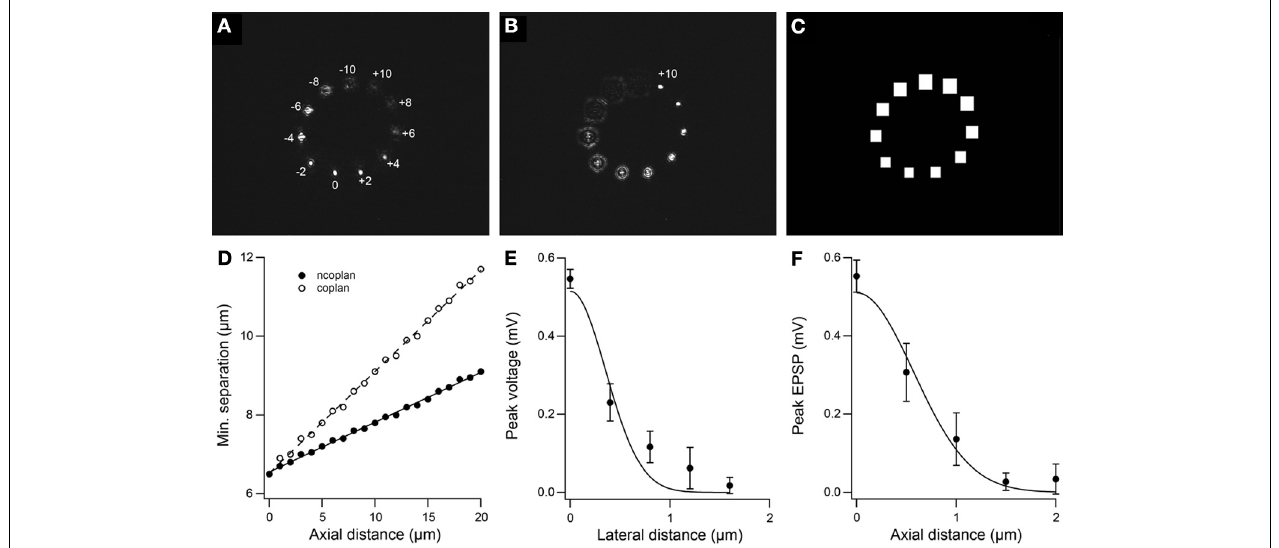
FIGURE 3 | Spatial resolution of independent gating and uncaging. (A) 3D photostimulation pattern with objective lens focused in the reference plane z = 0 μ m and the other 10 sites holographically projected either above (negative) or below (positive) the reference plane. (B) Same photostimulation pattern as in C but with objective lens focused in the plane z = + 10 μ m. (C) Sizes of micro-mirror arrays for switching foci shown in A . The array size scales with distance from the objective focal plane allowing collection of out-of-focus